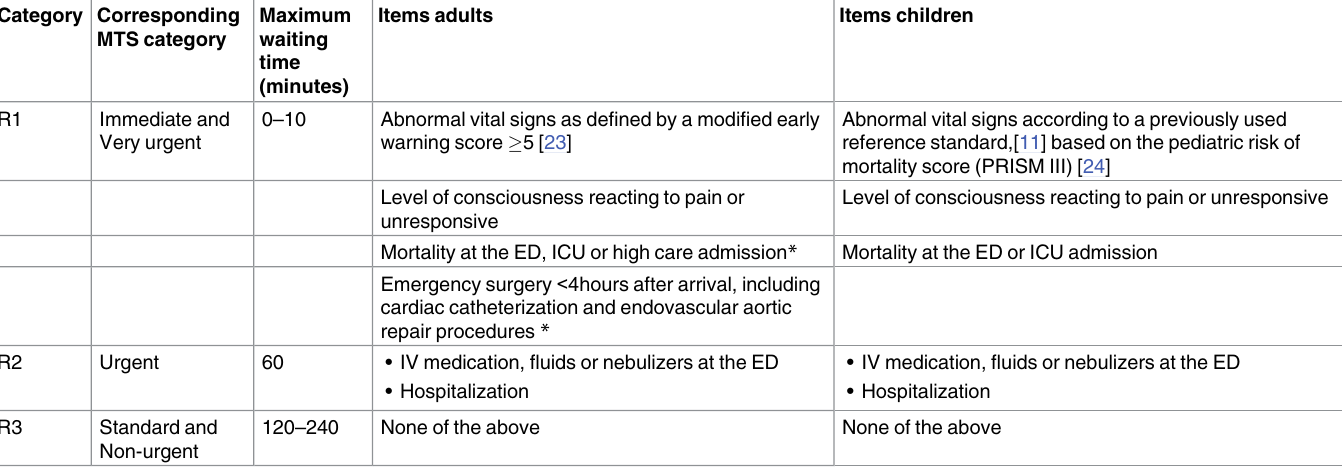
Table 1. 3-category referencestandard as proxy for true patient urgency. Category Corresponding MTS